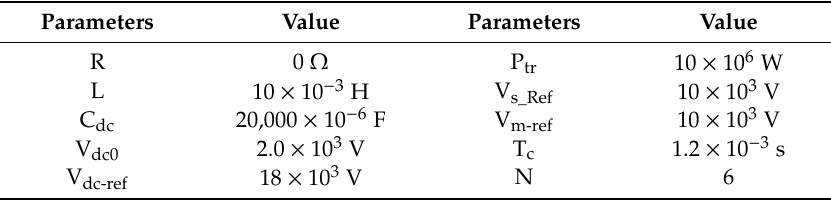
Figure 7. Zero-sequence current optimization. Table 1. Hexverter Parameters Used in Simulation.